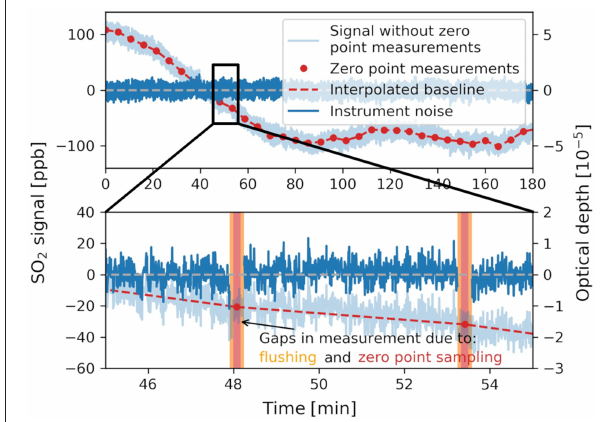
FIGURE 4 | Instrument noise (dark blue curve) at a detector integration time t int 0.5s and a reference interval T ref 5min. Red dots indicate zero point = = measurements from which drift can be inferred and subtracted. Top : 180 min time interval, Bottom : zoom into a 9min section. Additional graphs are for explanatory reason (see text for